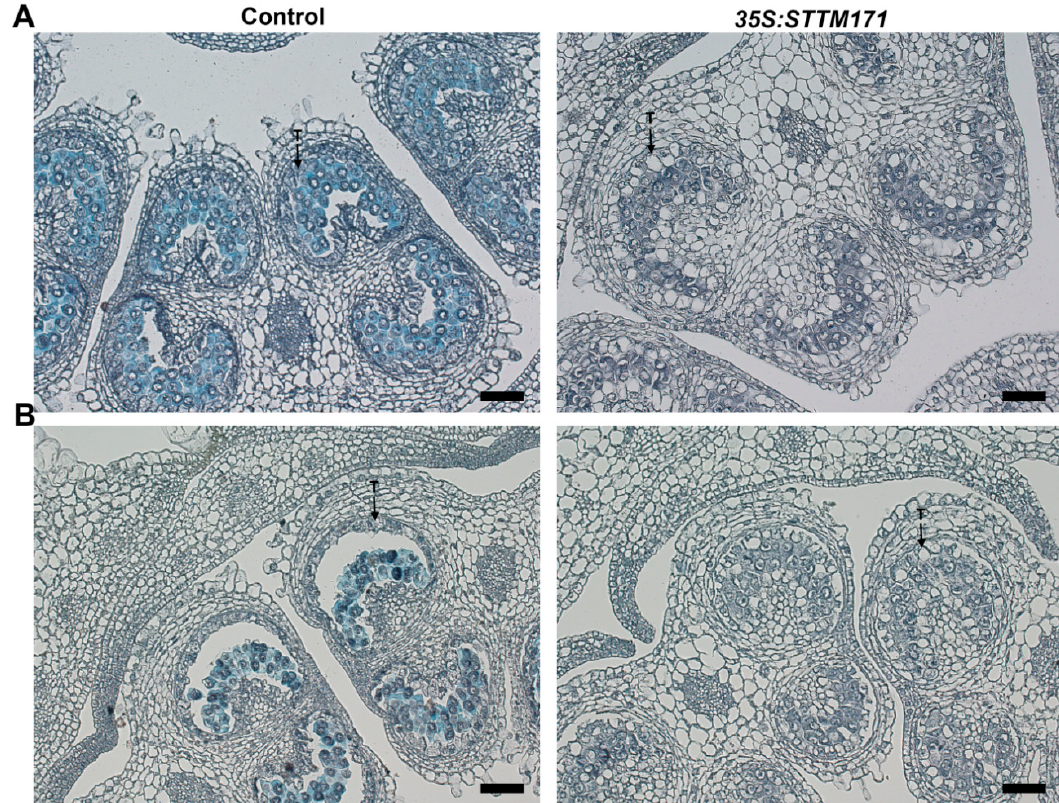
Figure 7. Callose detection in control and 35S:STTM171 anthers. Pictures of Lacmoid stained cross sections of anthers at the meiosis ( A , 4 mm bud) and tetrad ( B , 5 mm bud) stages are shown. T-tapetum. Scale bars = 20 µm.